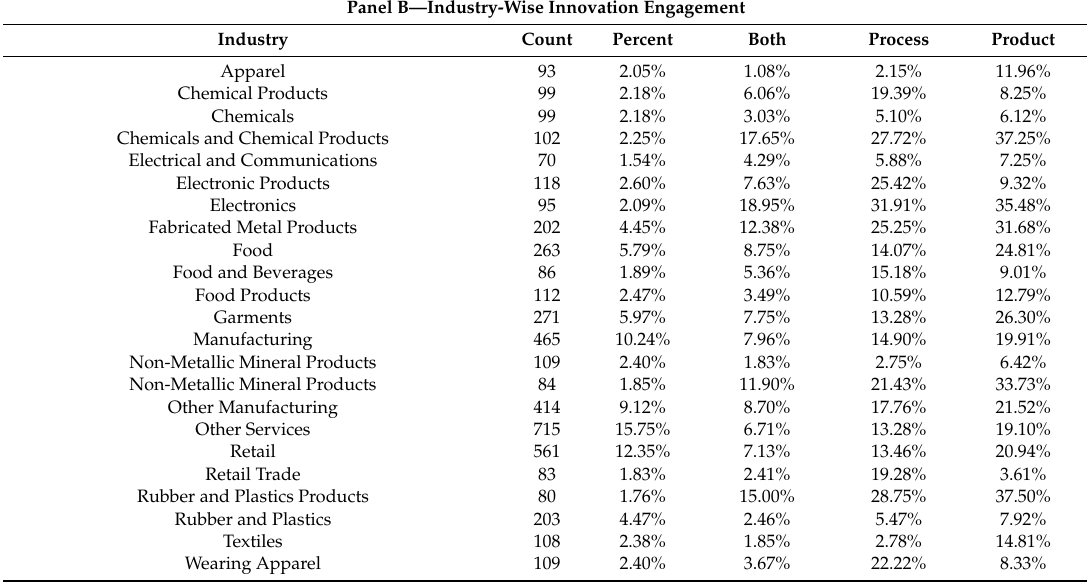
Panel B—Industry-Wise Innovation